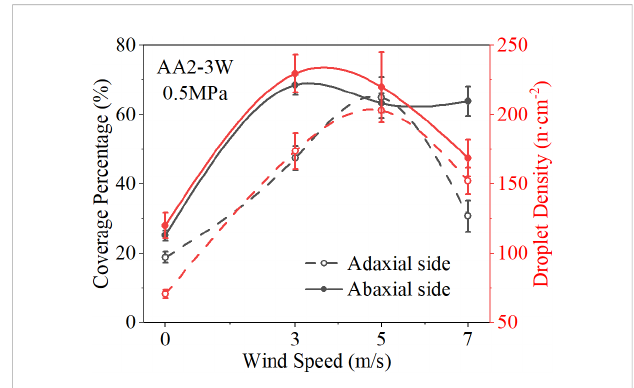
FIGURE 7 Response of Spray Deposition Distribution to Wind Speed (AA2-3W, SP = 0.5MPa).